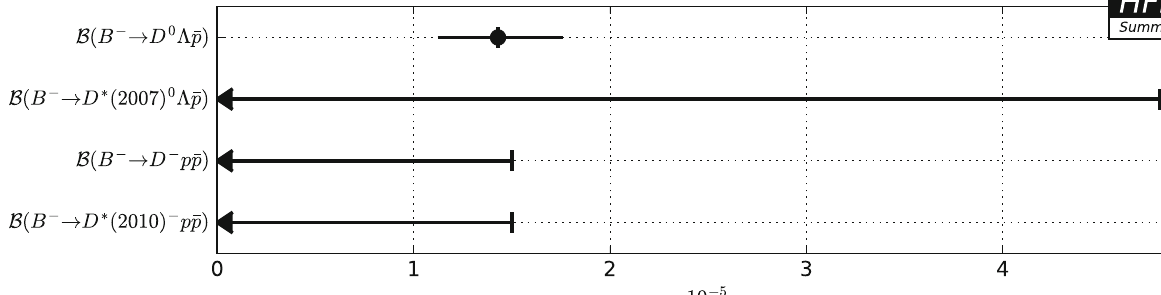
Fig. 118 Summary of the averages from Table 148